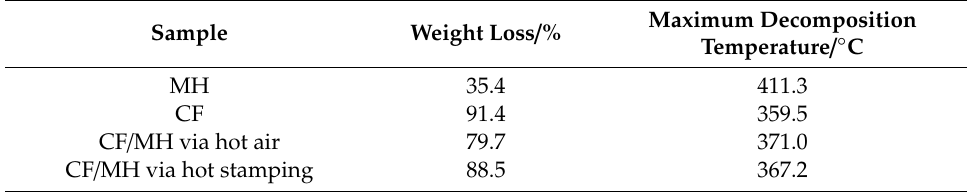
Figure 5. TGA and DTG curves of CF, MH, and CF / MH via hot air and CF / MH via hot stamping. Table 3. The thermal decomposition temperature and weight loss of MH, CF, and CF / MH via hot air and hot stamping.